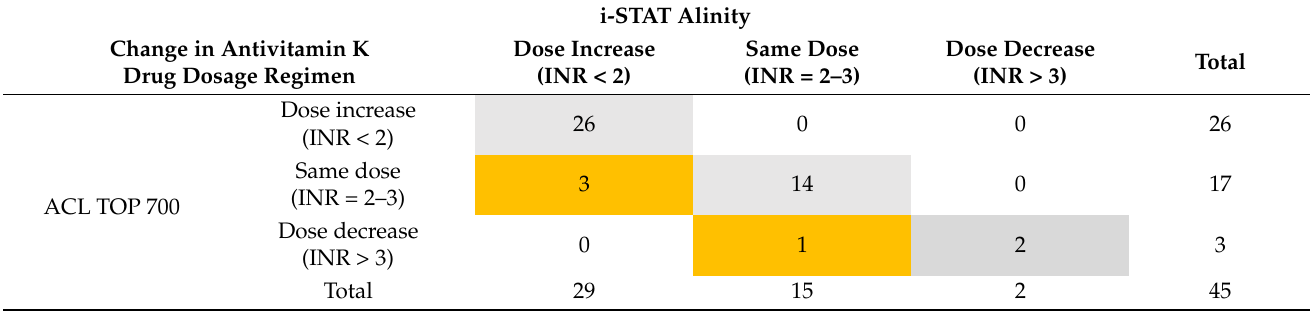
Abbreviations: INR = international normalized ratio. INR target according to the 2020 European Society of Cardiology (ESC) guidelines for the diagnosis and management of atrial fibrillation [11]. Concordant (grey) and discordant (orange)